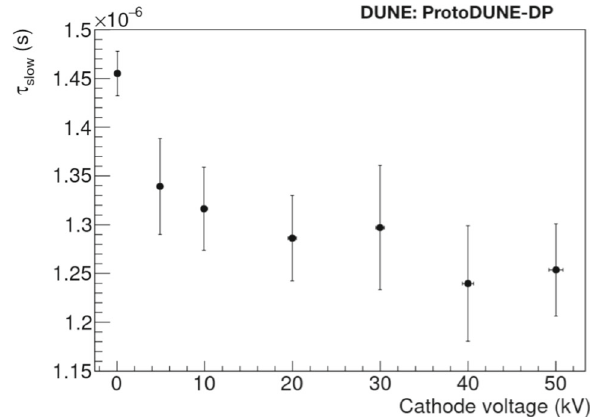
Fig. 19 Evolution of τ slow with the cathode voltage for CRT-trigger events. The results are obtained averaging PEN PMTs and the error bars indicate the STD among